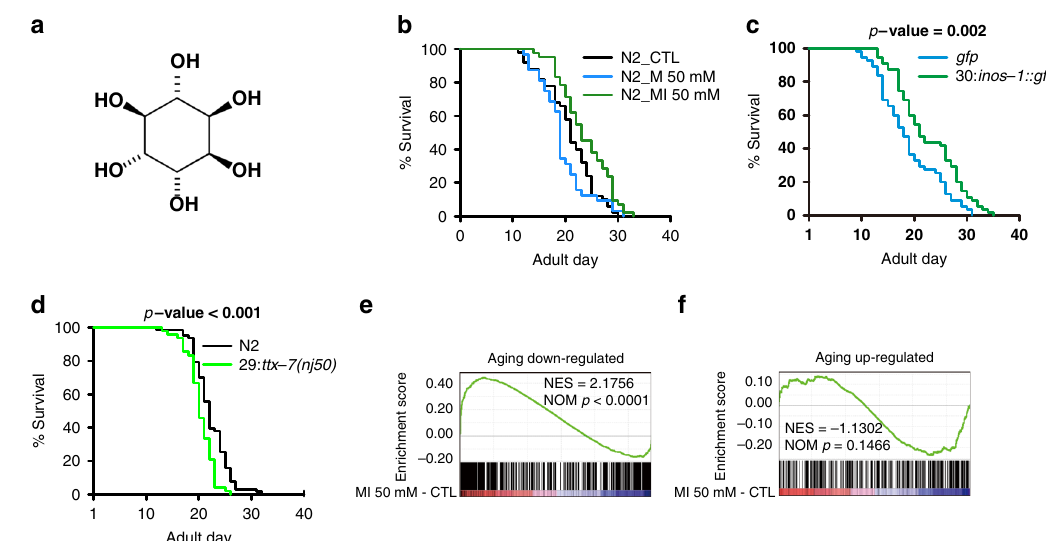
Fig. 1 MI promotes worm longevity. a Chemical structure of MI. b Survival curves of N2 worms treated with or without 50 mM M (log-rank test p < 0.001) or MI ( p < 0.01), N = 10. c Survival curves of inos-1 OE and control N2 worms (log-rank test p = 0.002). The number before “ : ” in a label indicates the reaction step in Fig. 4a, N = 11. d Survival curves of ttx-7 LOF and control N2 worms (log rank test p = 2.00E-04), N = 5. e , f GSEA results show worm aging downregulated or upregulated gene expressions measured by RNA-seq FPKM log 2 -fold-change, were reversely regulated by 50 mM MI (GSEA p < 0.0001 for aging downregulated genes and p = 0.1466 for aging upregulated genes, respectively), N = 1. Source data are provided as a Source Data fi le and Supplementary Dataset